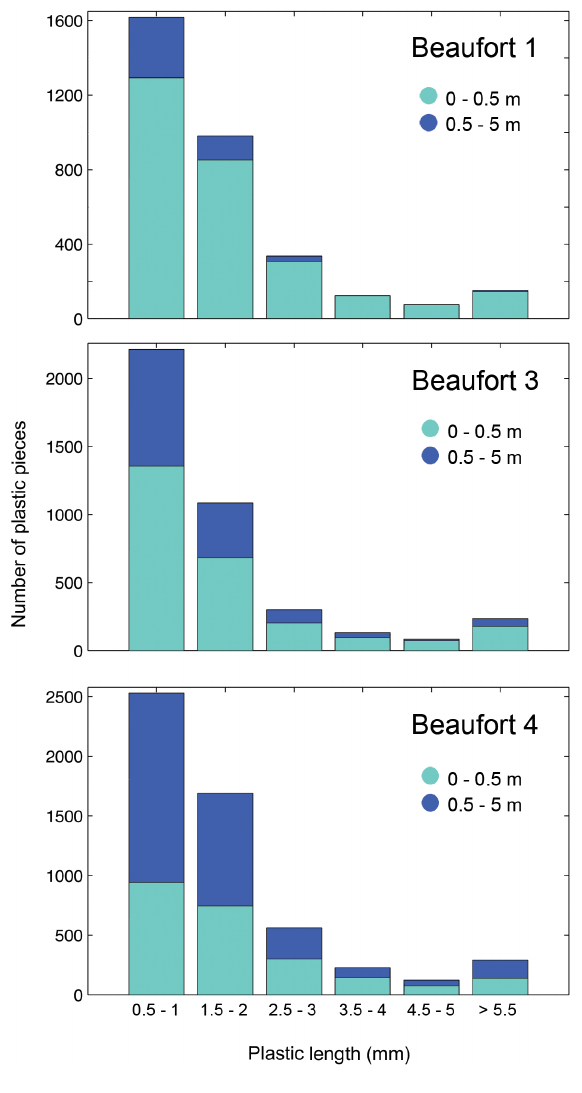
Figure 6. Size histograms of plastics collected at depths 0–0.5 and 0.5–5m during Beaufort numbers 1 (top panel), 3 (middle panel), and 4 (bottom panel).